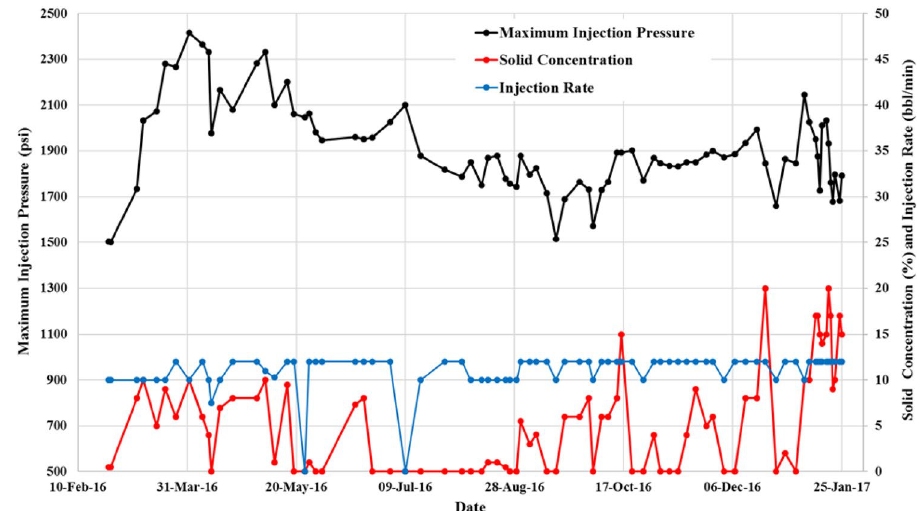
Fig. 10 Variation of the maximum injection pressure of each batch with injection rate. The increase of 2 bbl/min in injection rate keeps injection pressure below or slightly higher than 2100 psi for various solid volume concentrations up to